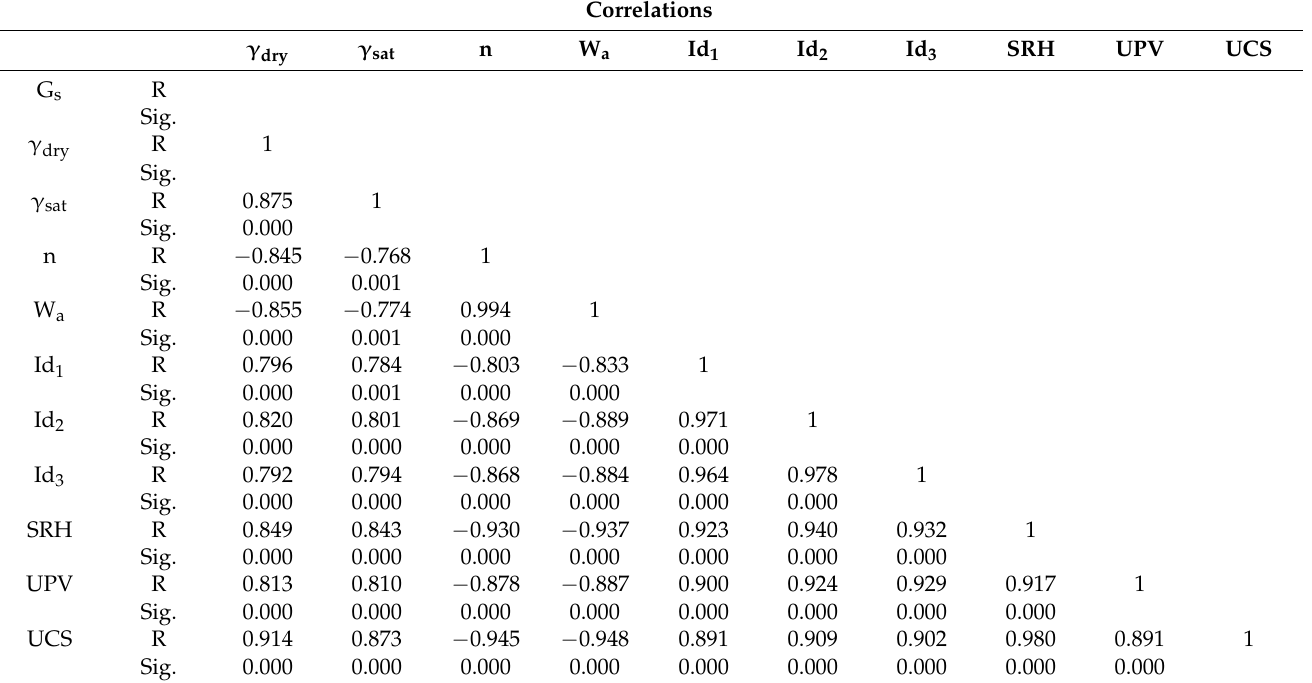
Table 3. Descriptive results of linear regression analysis for correlating the engineering properties of the rocks.